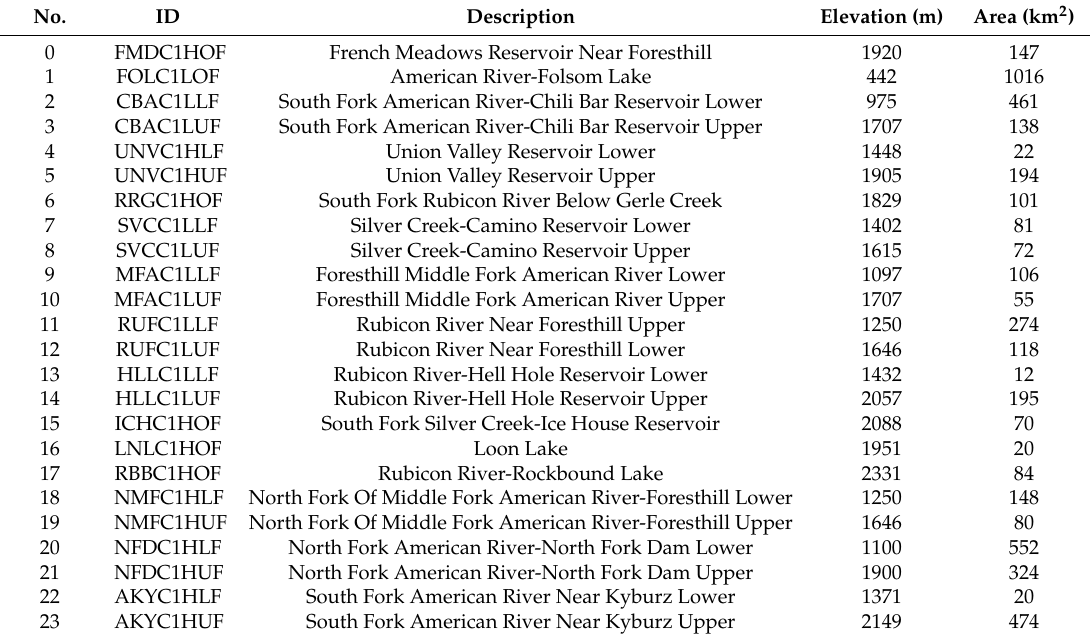
Table A3. Study basins in the American Group.